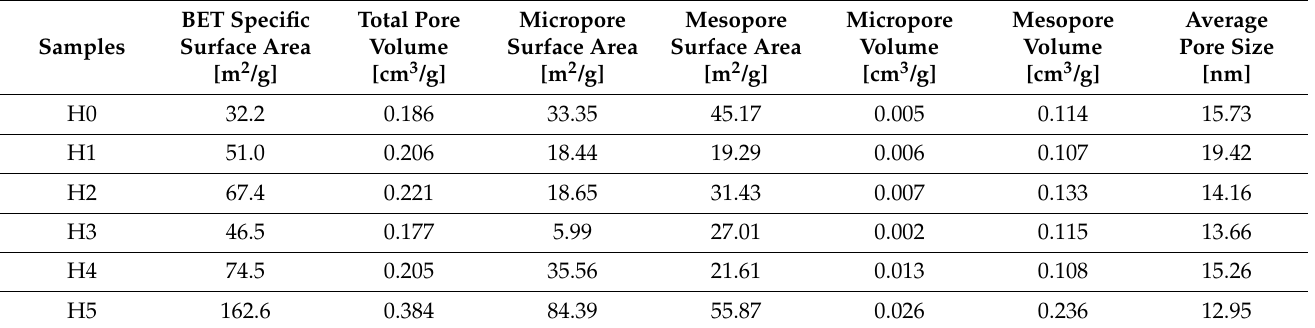
Table 5. Specific surface area (S BET ), total pore volume (V t ), mesopore volume (V mes ), micropore volume (V mic ), and average pore size (d) of raw and modified halloysite samples. Samples, treatment details, and names are described in Table